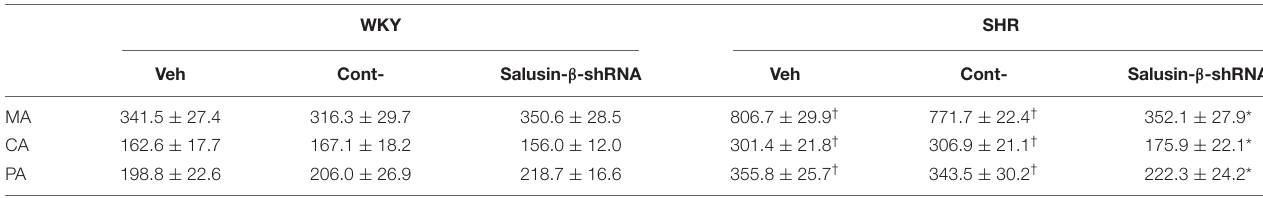
Values are expressed as mean ± SE. *P < 0.05 vs. Veh or Cont-shRNA. † P < 0.05 vs. WKY. n = 6 for each